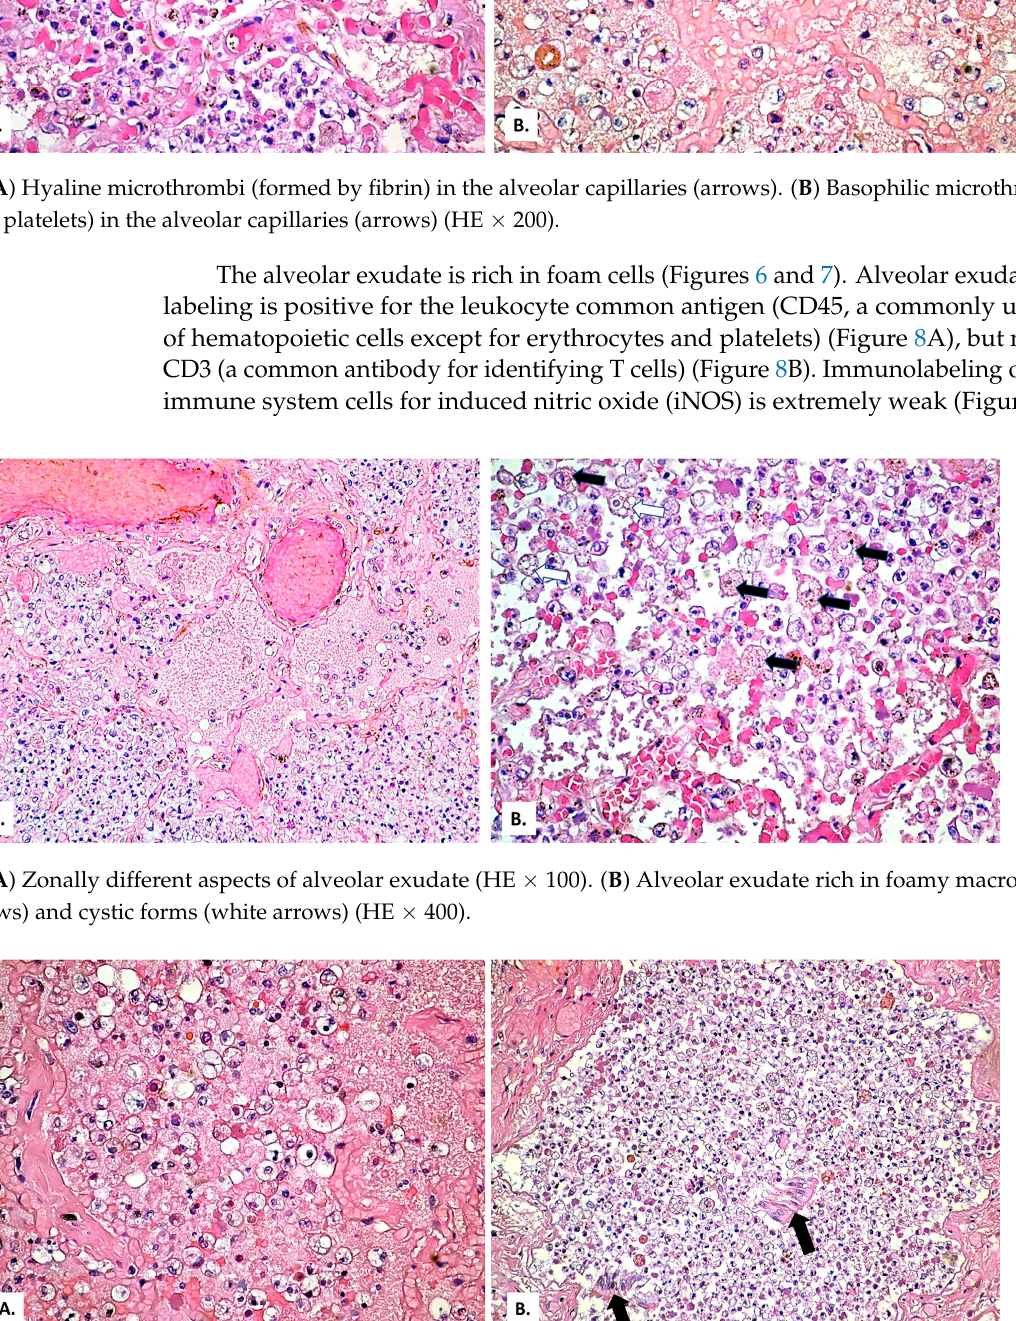
Figure 8. ( A ) Immunolabeling with leukocyte common antigen (CD45) (×40). ( B ) Immunolabeling with CD3 (×200).